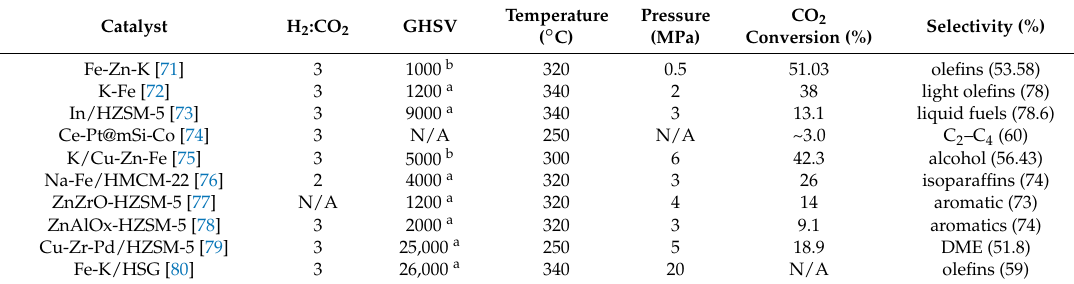
Table 4. Catalytic activity of several catalysts for CO 2 hydrogenation into other products (e.g., DME, olefins, alcohol, isoparaffins, gasoline, aromatics), in terms of CO 2 conversion and product selectivity, along with the reaction